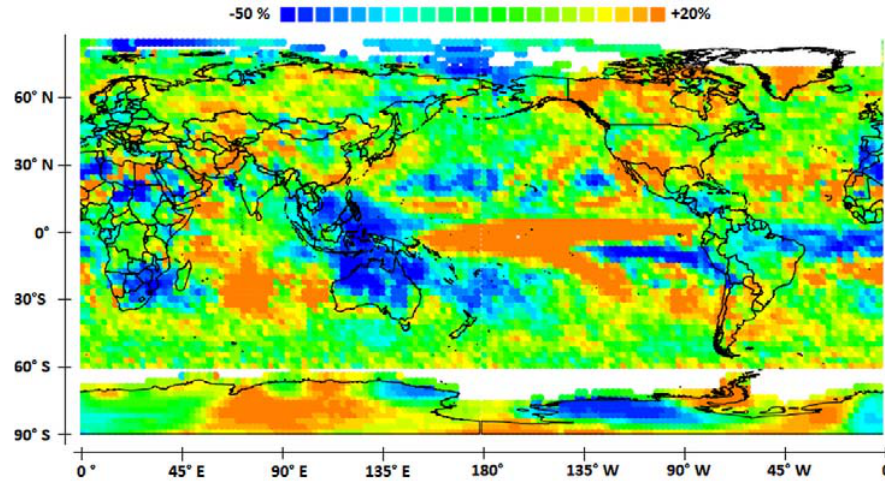
Figure 9. Impact of the ENSO from the variability of precipitation height. Strongly lagged events are considered.